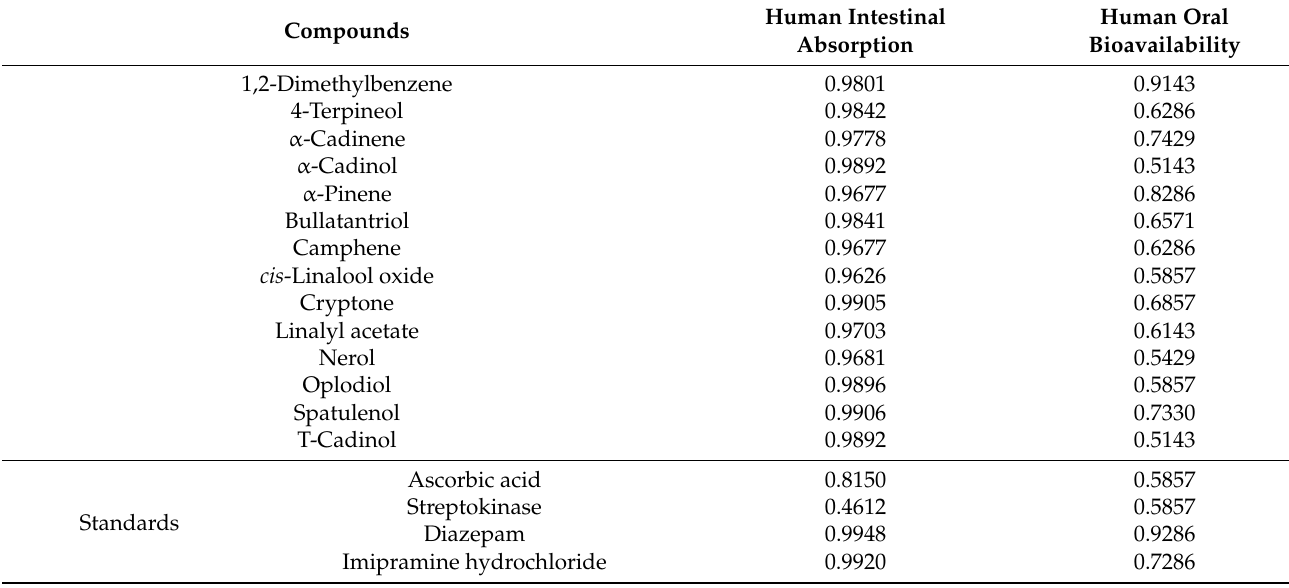
Table 8. Additional pharmacokinetic profiling (absorption and oral bioavailability) of the phytochemical compounds of essential oil in leaves of H.